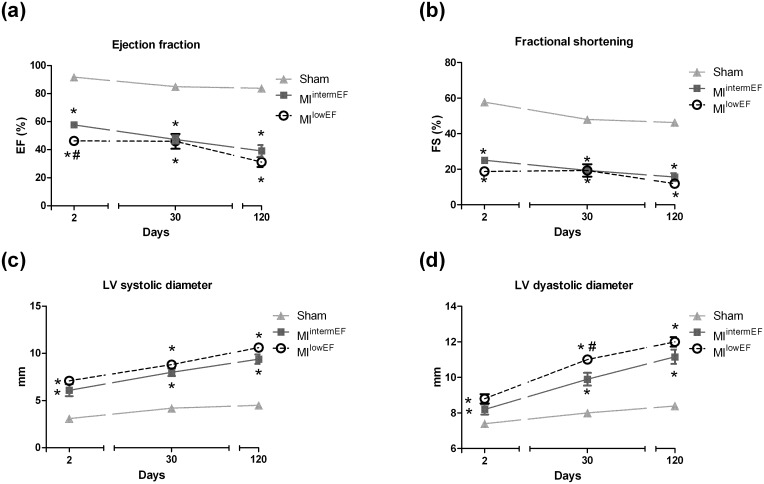
Echocardiographic data collected over the time.Ejection fraction (a), Fractional shortening (b), LV systolic volume (c), and LV diastolic volume (d) were recorded up to 120 days of follow-up. Generalized estimating equations. Data expressed as mean ± SE. * Difference vs. sham; # difference vs. MIintermEF (p < 0.01; sham group, n = 15; MI group, n = 7 per group). MIintermEF: EF > 53.7% and < 66.5%; MIlowEF: EF < 53.7.